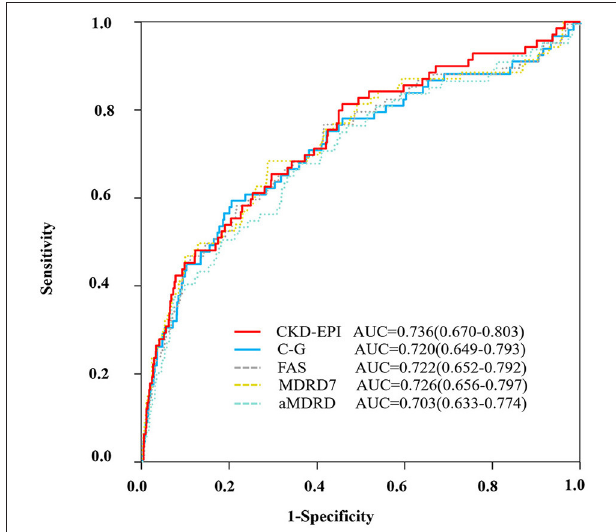
FIGURE 1 | ROC curve. ROC curve to evaluate the diagnostic performance of the ratio of CV/GFR to predict CIN according to the different equations (CKD-EPI, C-G, FAS, MDRD7, and aMDRD). aMDRD, abbreviated modification of diet in renal disease; AUC, area under the receiver operating characteristics curve; C-G, cockcroft–gault; CKD-EPI, chronic kidney disease epidemiology collaboration; FAS, full age spectrum; MDRD, modification of diet in renal disease study.